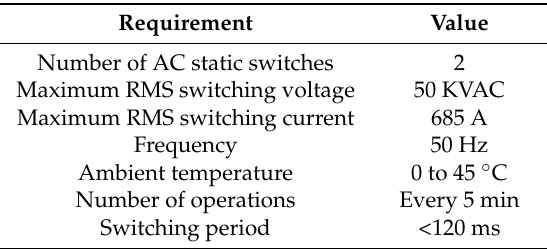
Table 3. AC static switch for neutral section